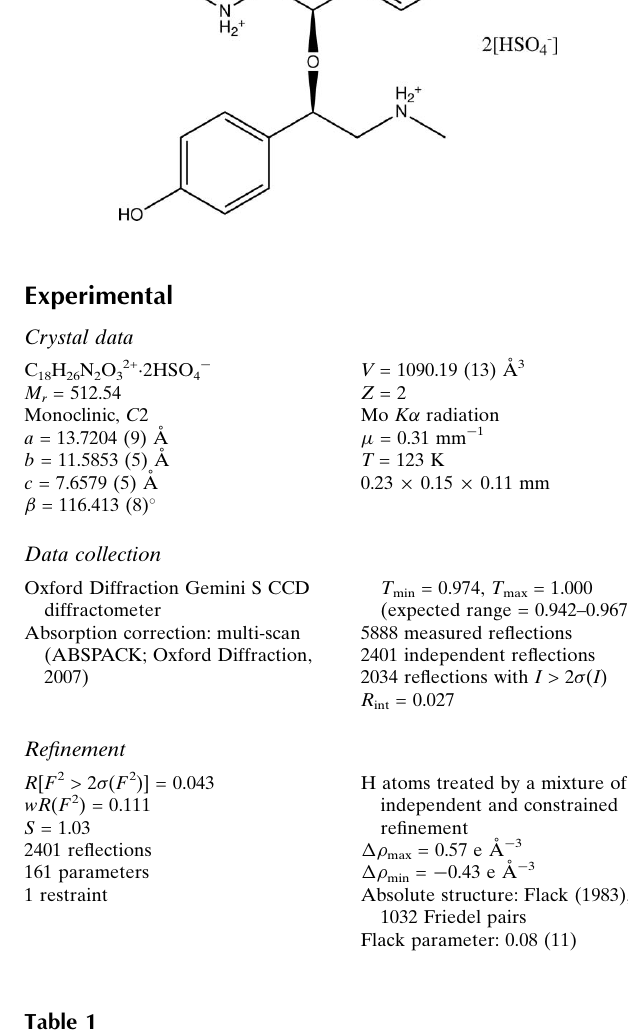
Hydrogen-bond geometry (A ˚ , (cid:4) ). D —H (cid:2)(cid:2)(cid:2) A D —H